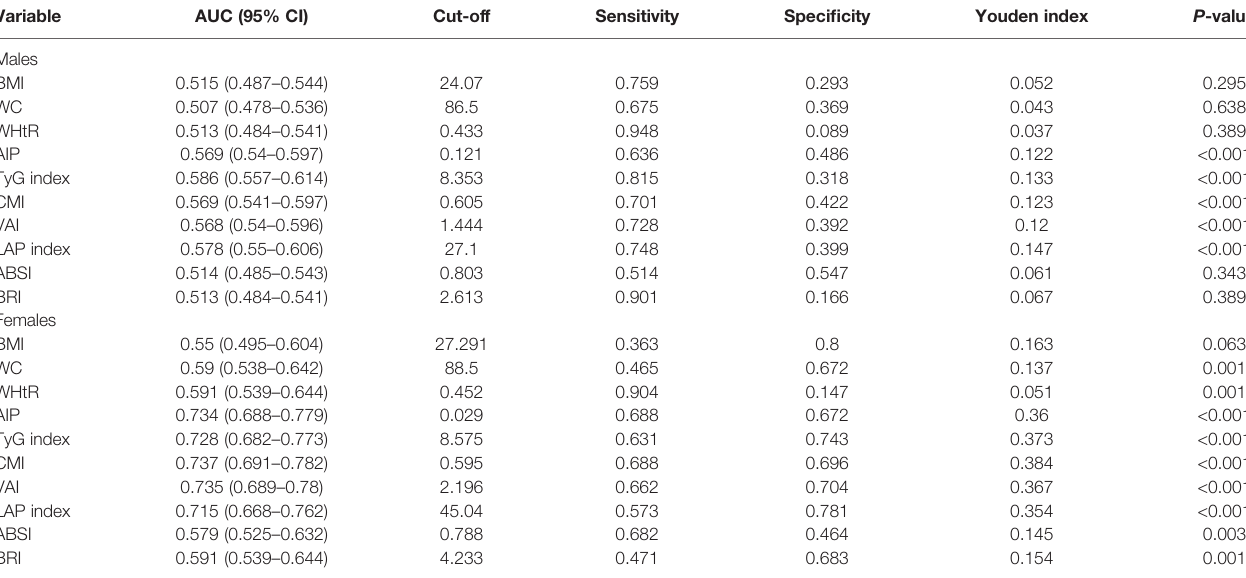
TABLE 5 | Comparison of the ability of different indices to predict HUA.